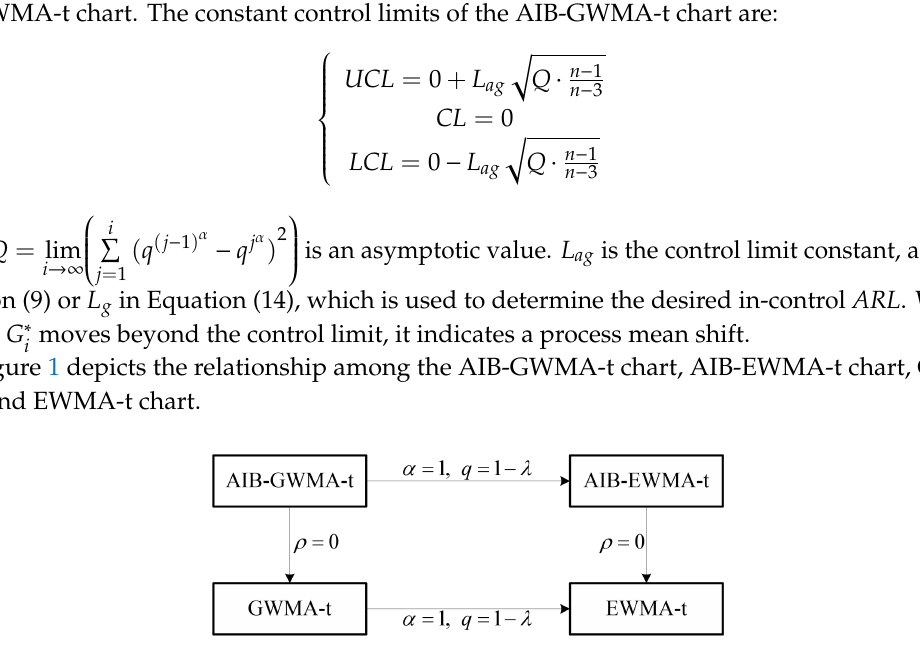
Figure 1. The structure of the AIB‐GWMA‐t chart and its special cases.